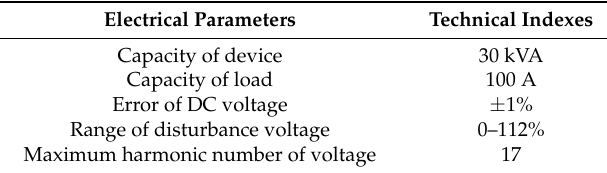
Figure 15. Structure diagram of the physical prototype. Table 3. Technical indices of device.